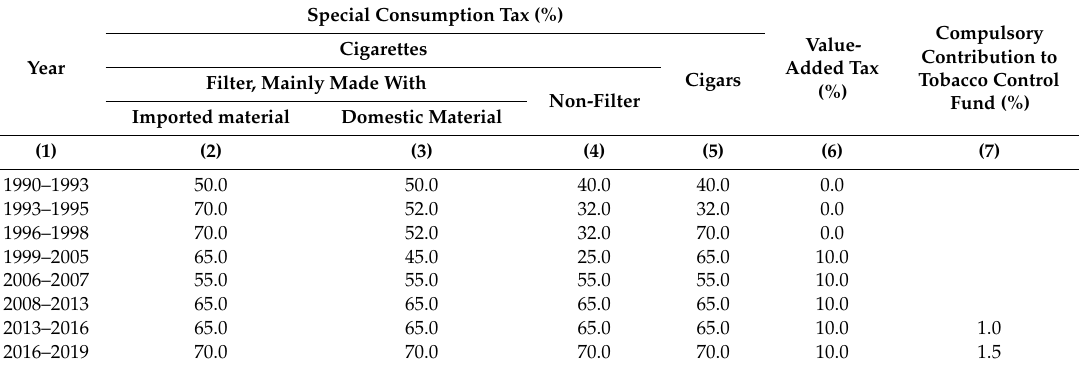
Table A1. Tobacco Tax Rates,